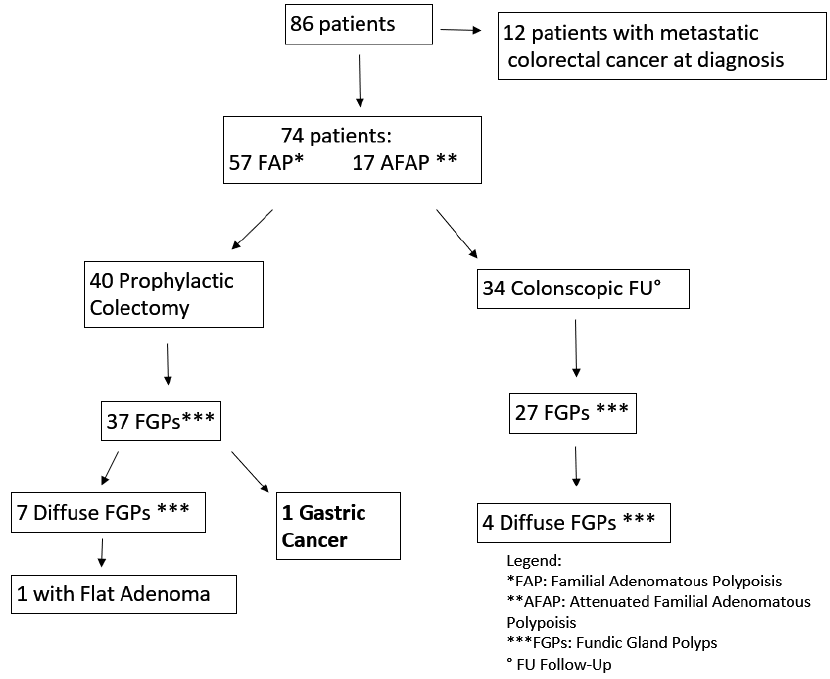
Figure 8. Familial adenomatous polyposis (FAP) patients.